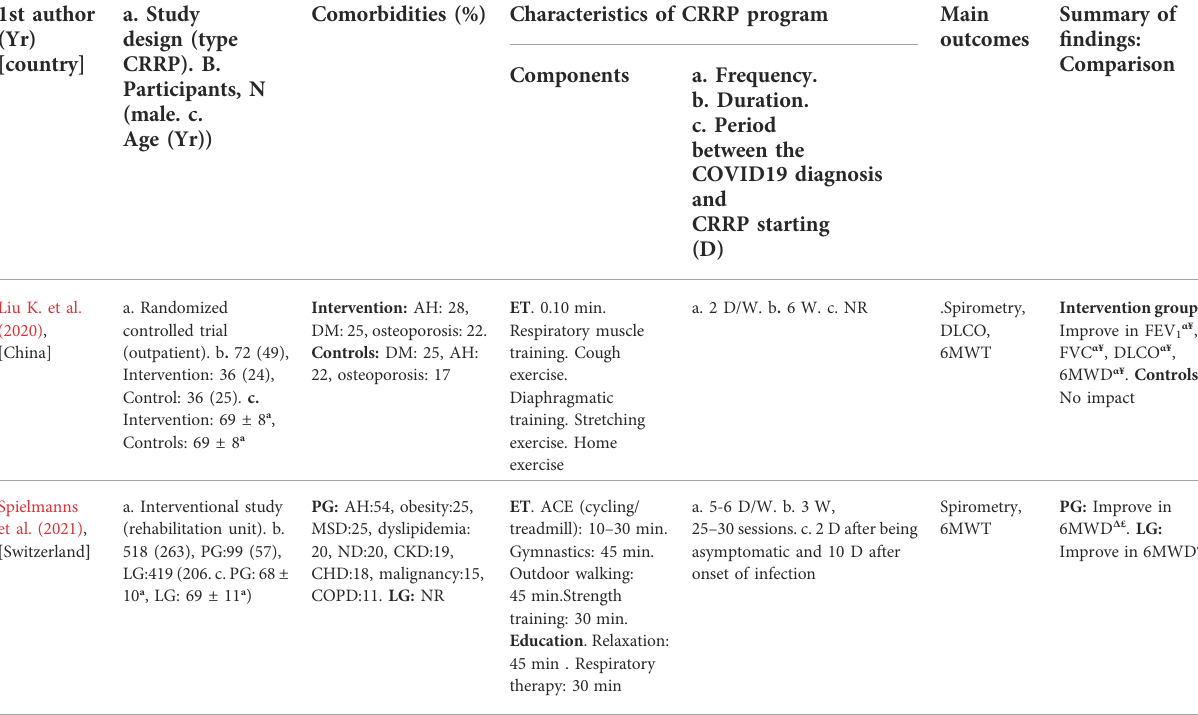
TABLE 5 Methodology and main outcomes of some case-control studies aiming at evaluating the impact of CRRP on COVID19